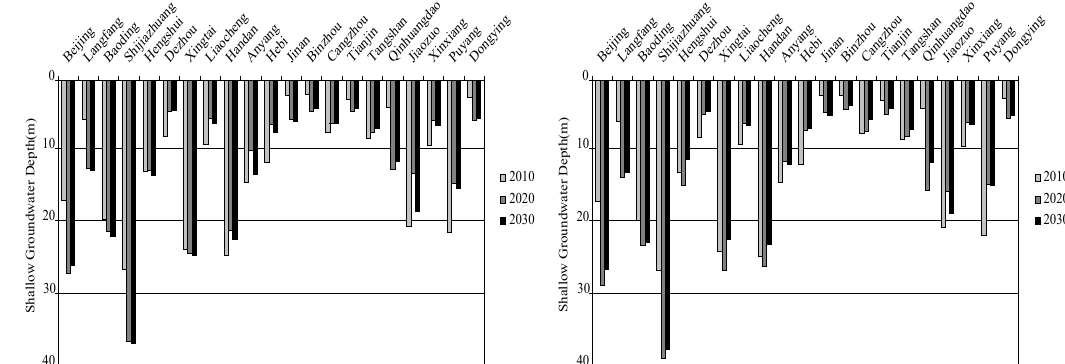
Fig. 6 Shallow-groundwater depth change of schemes F4 and F5, from 1980 to